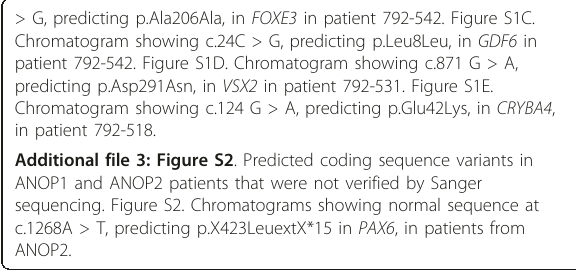
Additional file 3: Figure S2 . Predicted coding sequence variants in ANOP1 and ANOP2 patients that were not verified by Sanger sequencing. Figure S2. Chromatograms showing normal sequence at c.1268A > T, predicting p.X423LeuextX*15 in PAX6 , in patients from